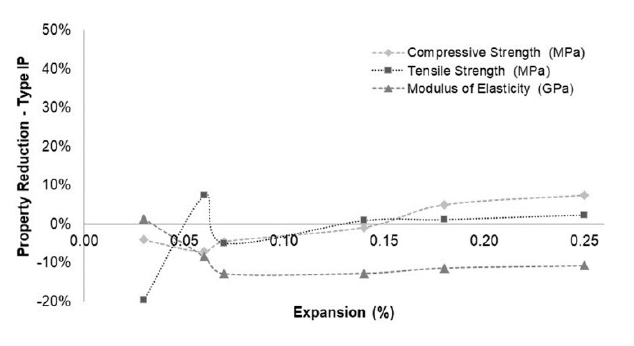
Figure 14. Correlation between the mechanical properties and expansion for Type IP